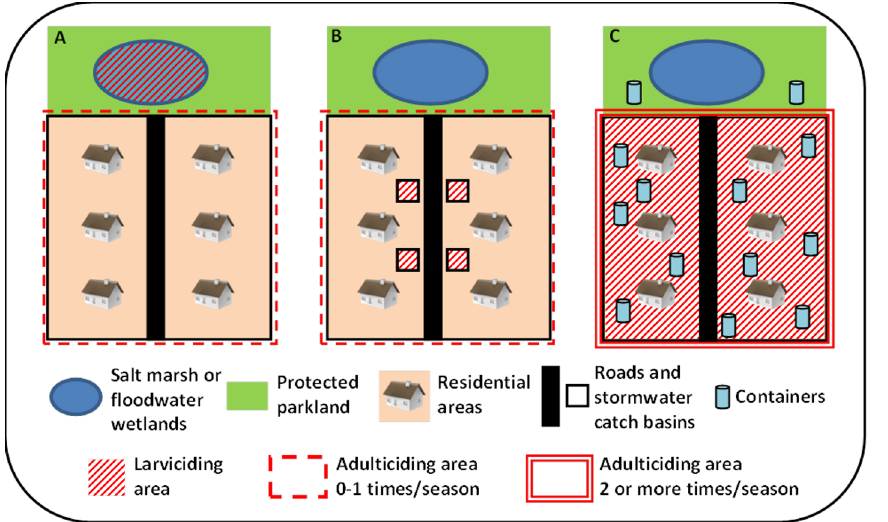
Figure 3. Schematic representation of mosquito habitat and control paradigm. ( A ) Salt marsh and floodwater Aedes spp. emerge outside of residential areas and may be effectively controlled at the larval wetland habitat with timely larvicide applications (no adulticiding required). Heavy infestation may require infrequent (usually once per season) adulticide applications. ( B ) Urban Culex spp. utilize manmade stormwater structures within the residential areas. Delayed release larvicide formulations are very effective in suppressing Culex spp. emergence. In the years with high WNV activity, a timely adulticide application may be required for prevention of virus transmission to humans. ( C ) Ae. albopictus is a container-inhabiting species whose larval habitat is unpredictable and widespread throughout the residential as well as the adjacent natural areas. Effective control of biting adults may require combined areawide larvicide and adulticide applications, likely to be repeated multiple times during a mosquito season. doi:10.1371/journal.pone.0060874.g003 PLOS ONE |